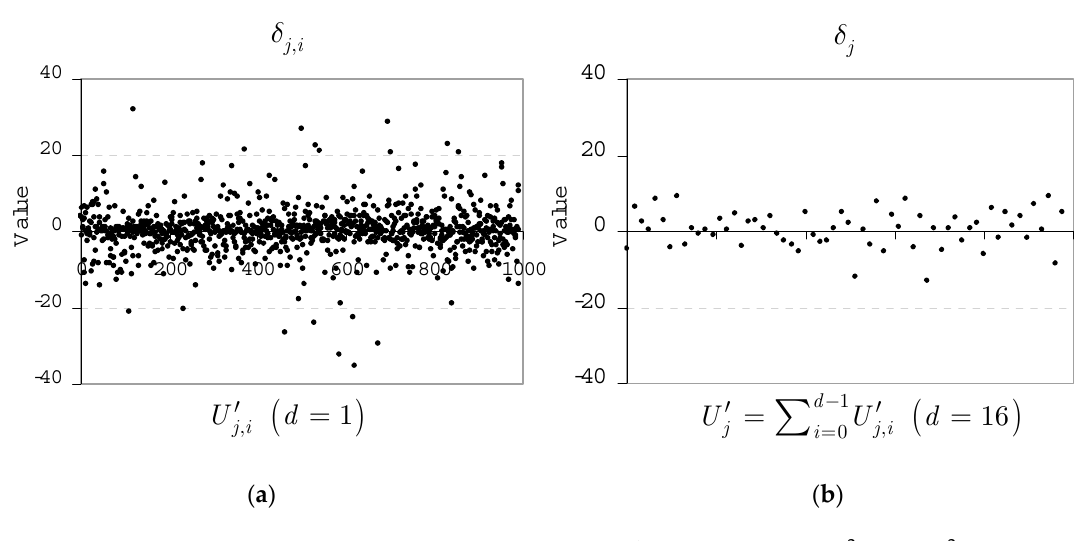
= 100, σ 2 = 104; X X (cid:48)